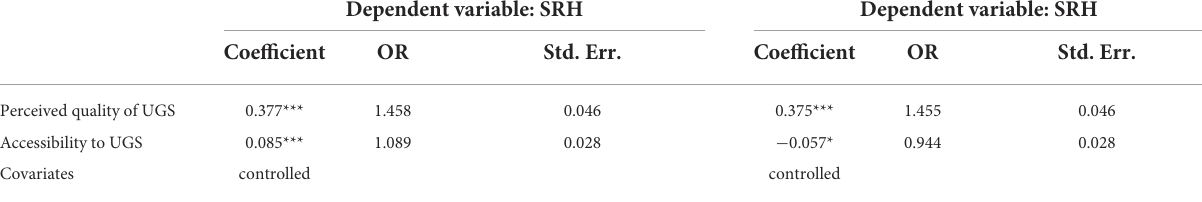
TABLE 6 Heterogeneous effects of urban park types on respondents’